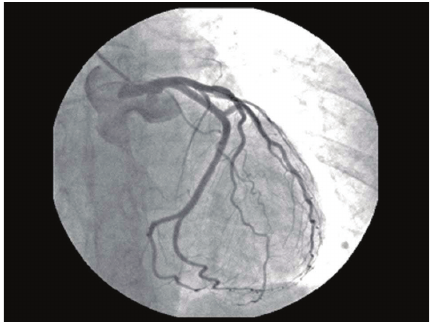
Figure 3: Angiographic image showing normal coronary arteries.